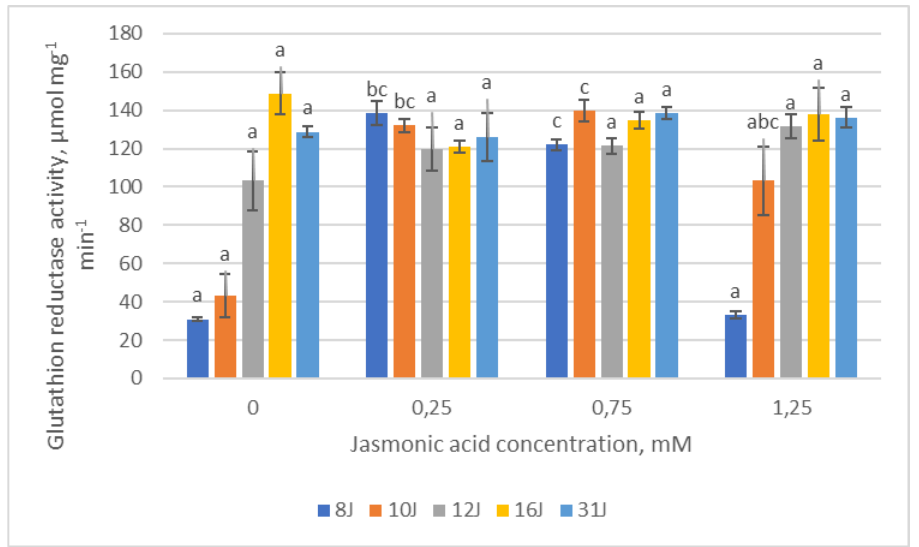
Figure 7. Means (µmol mg − 1 min − 1 ) ± SE of glutathione reductase (GR) activity in five half-sib families of Scots pine, assessed 6 weeks after sowing. Data significance was calculated using the Kruskal – Wallis H test for ranks and post hoc Dunn ’ s test for pairs ( p < 0.05). Different letters next to different colors indicate significant differences between the groups, sprayed with different concentrations of jasmonic acid.